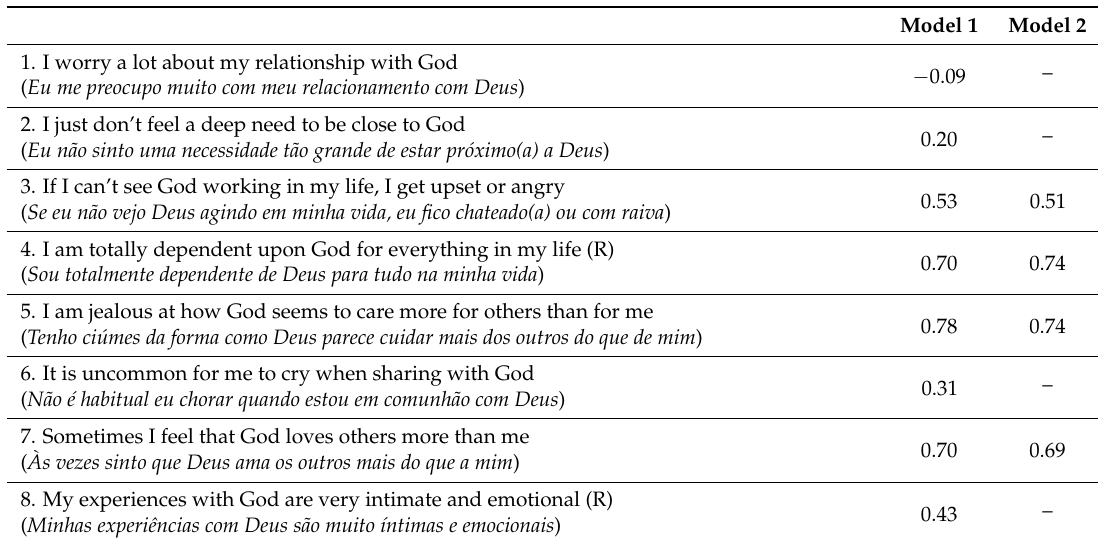
Table 1. Total-Item Correlation in Models 1 and